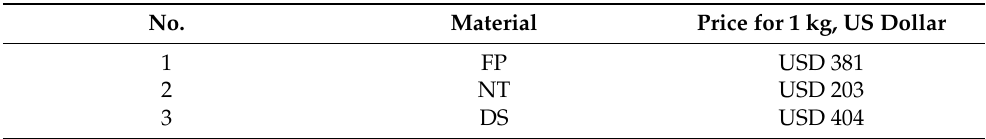
Table 8. The price for the dental material feedstocks (February 2023).